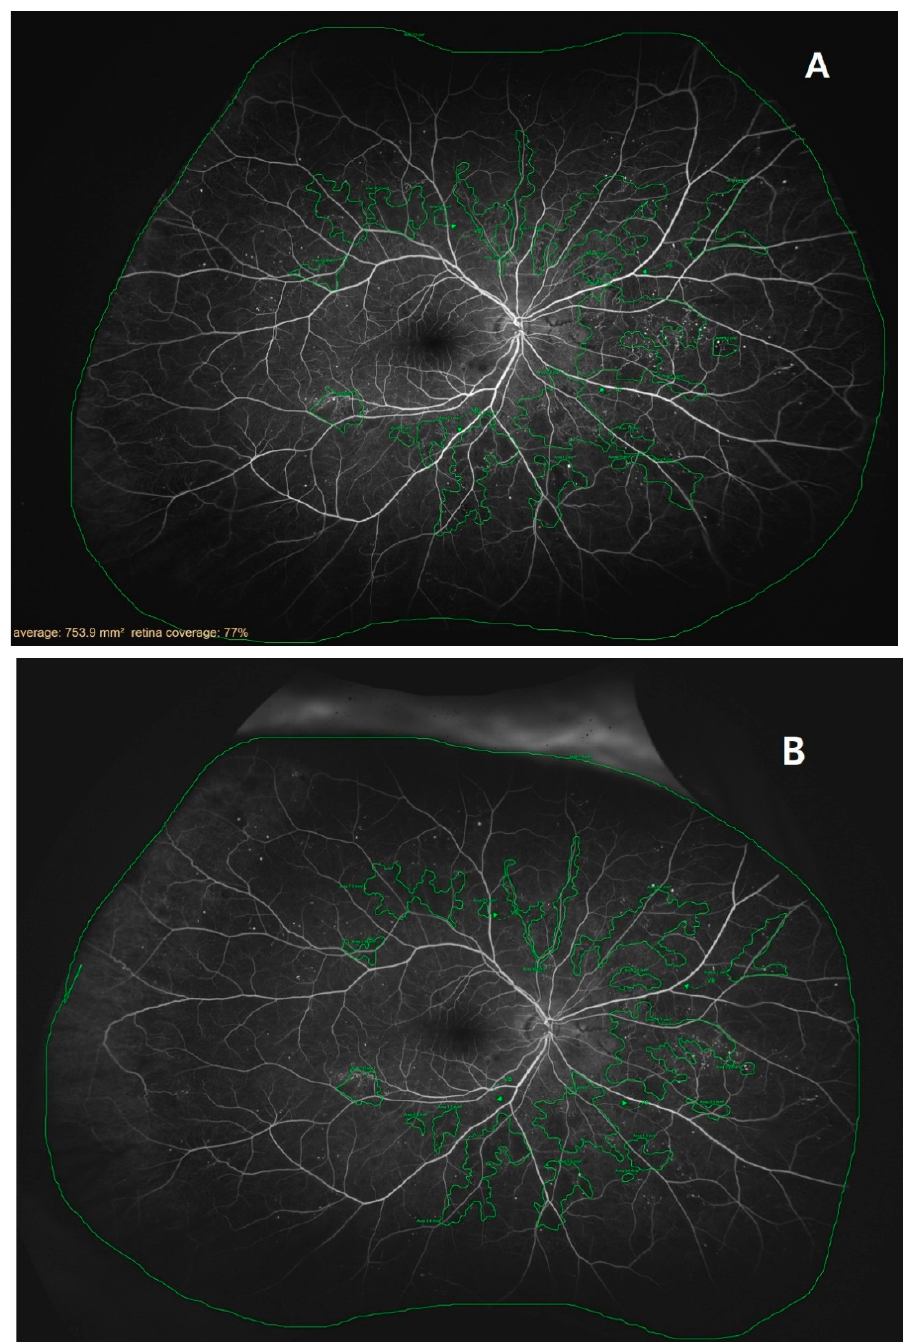
Figure 1. Example tracing images of retinas examined with ultrawide ‐ field fluorescein angiography: ( A ) a retina 2 weeks before the treatment (V1); ( B ) a retina 8 ± 1 weeks after the first treatment